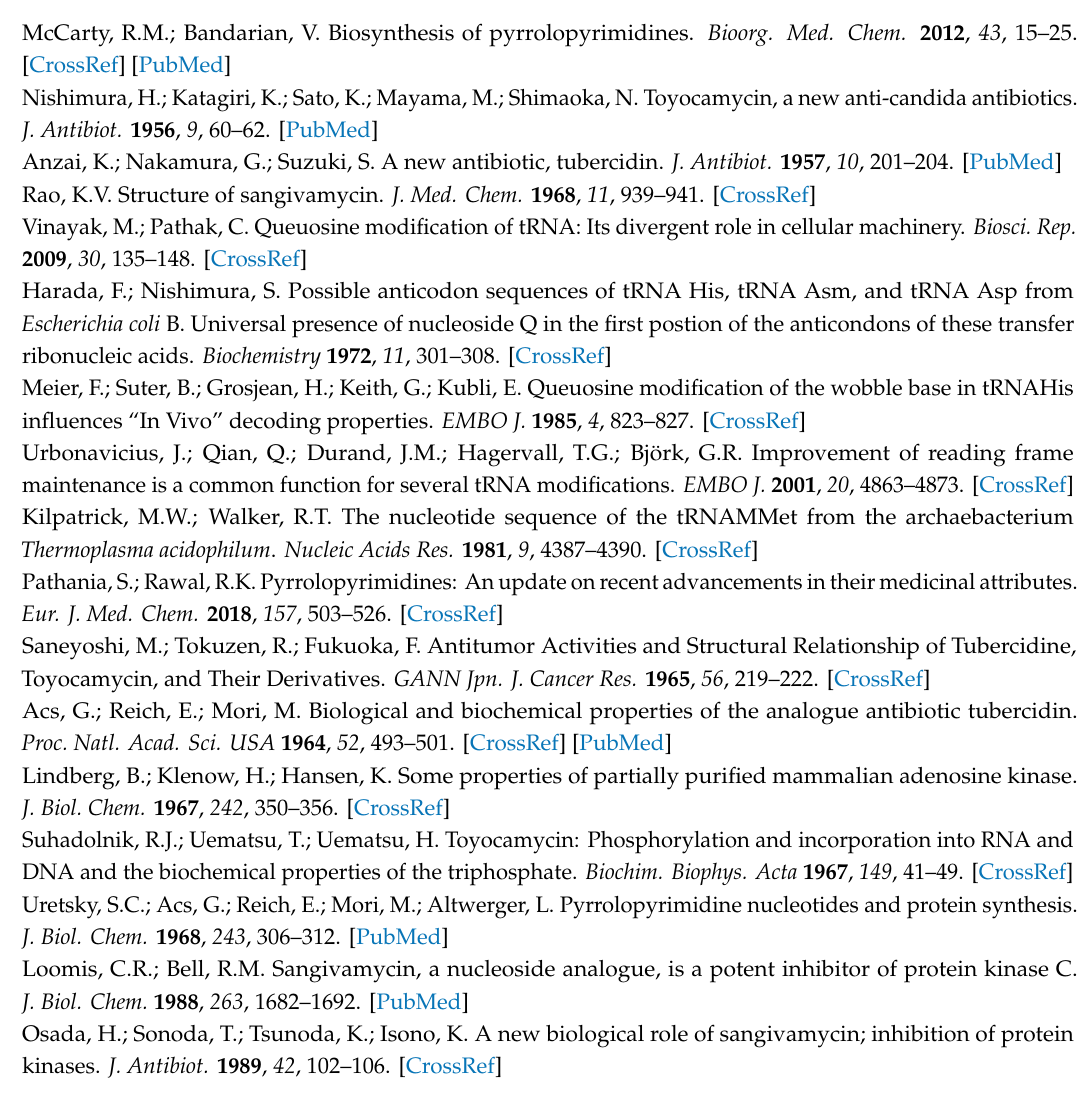
Figure S1: Restriction mapping of the BAC 2I16 and its derivatives with gene deletions, Figure S2: 1 H NMR (500 MHz, MeOD4) spectrum of huimycin 1, Figure S3: HSQC (500 MHz, MeOD4) spectrum of huimycin 1, Figure S4: HMBC (500 MHz, MeOD4) spectrum (CNST13 = 2 Hz) of huimycin 1, Figure S5: HMBC (500 MHz, MeOD4) spectrum (CNST13 = 6 Hz) of huimycin 1, Figure S6: HMBC (500 MHz, MeOD4) spectrum (CNST13 = 10 Hz) of huimycin 1, Figure S7: 1 H- 1 H COSY (500 MHz, MeOD4) spectrum of huimycin 1, Figure S8: TOSCY (500 MHz, MeOD4) spectrum of huimycin 1, Figure S9: ROESY (500 MHz, MeOD4) spectrum of huimycin 1, Table S1: Bacterial strains used in this work, Table S2: Plasmids and BACs used in this work, Table S3: Primers used in this